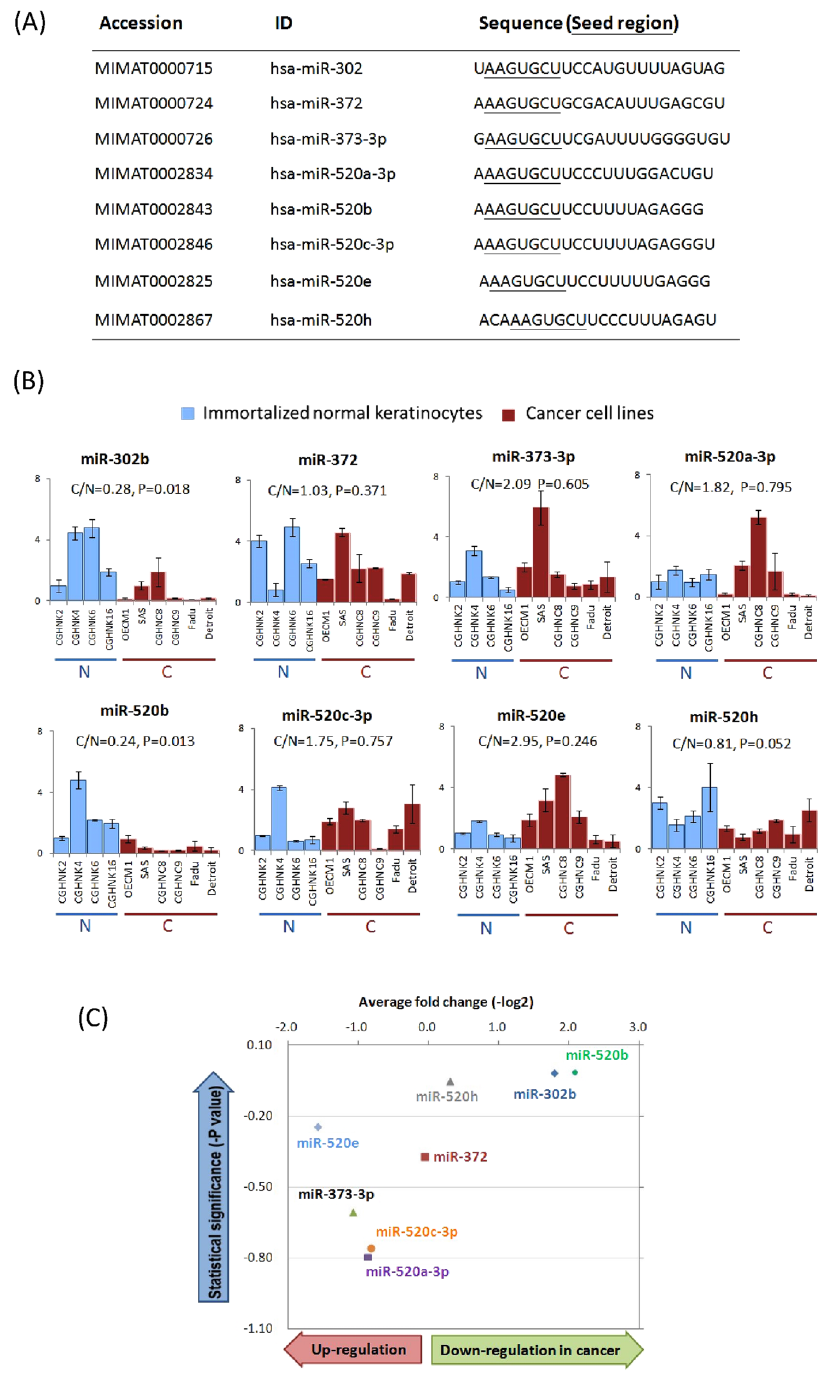
Figure 1. Differential expressions of miR-302/372/373/520 family members between normal keratinocytes and HNC cell lines. ( A ) The miR-302/372/373/520 family members are listed along with the relevant accession number, ID and sequence. Seed regions, which are underlined within the sequence, are the same among all members. ( B ) The relative expression levels of miRNAs of the miR-302/372/373/520 family in HNC cancer cell lines and normal keratinocytes were determined by RT-qPCR. The expression levels as recorded by threshold cycle numbers (Ct) were normalized against an internal control (U6 RNA), and the comparative threshold cycle method ( Δ Ct) was used to determine the relative miRNA expression. ( C ) The overall view of the differential expression of 8 miRNAs between cancerous and normal samples, with the average fold change (X-axis) and statistical P value (Y-axis) for each miRNA